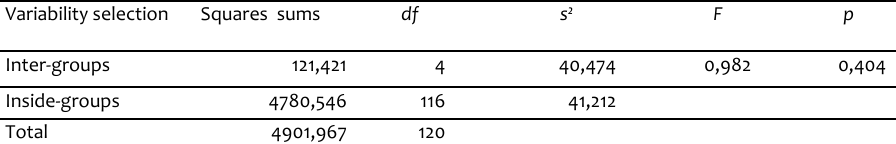
Table No. 4. Analysis of variances scores achieved by the teachers depending on the years of work experience at the scale established for assessment of the democratic work style in the teaching process